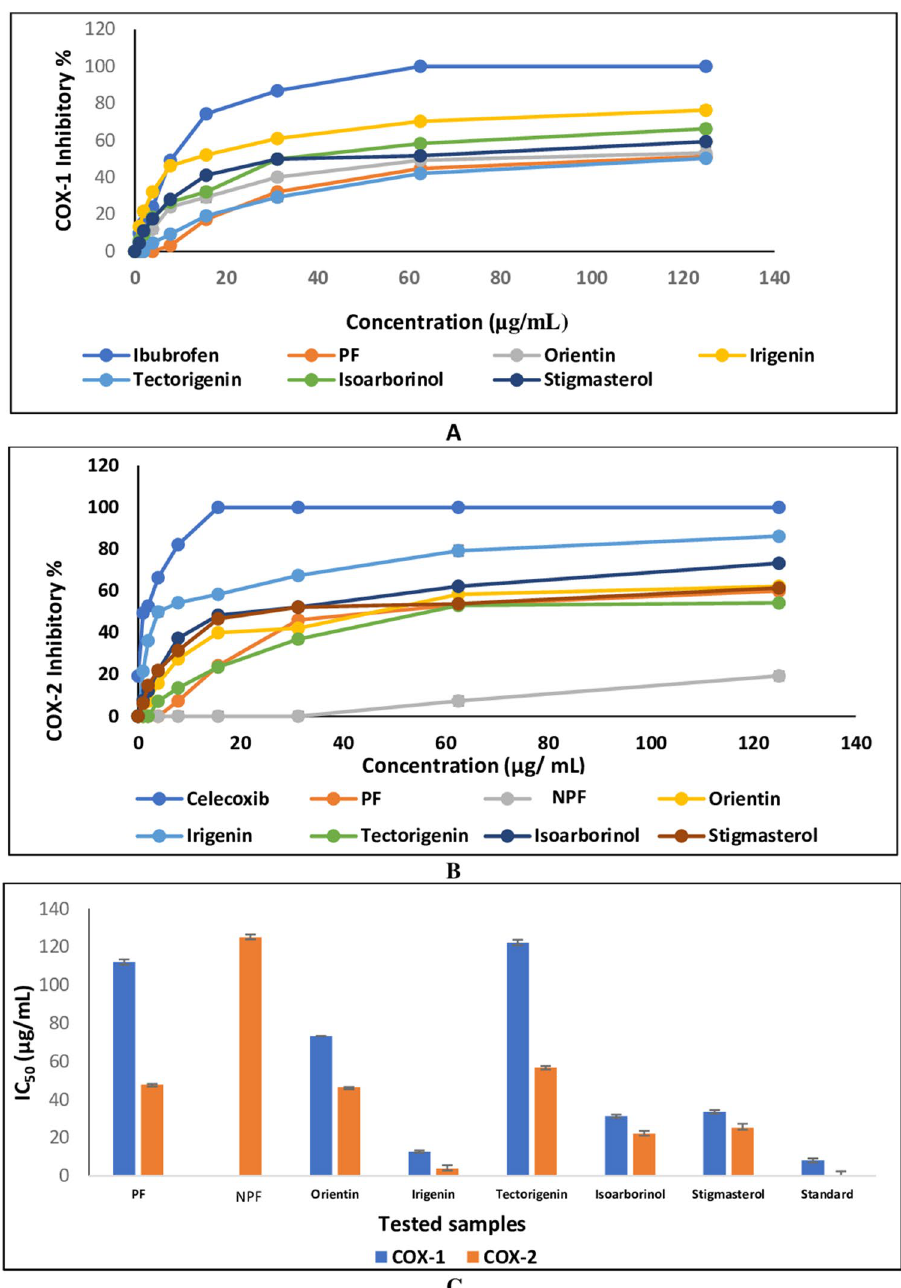
Figure 3. Effect of I. confusa underground parts PF, NPF and isolated compounds on ( A ) COX-1 and ( B ) COX-2 inhibition, ( C )